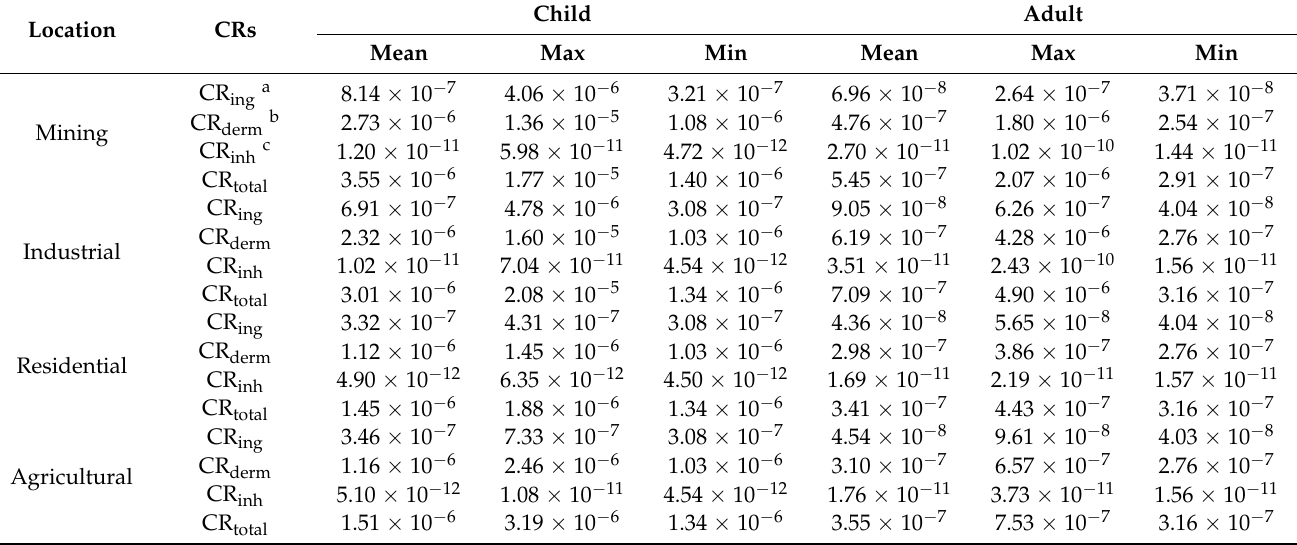
Table 2. Cancer risks for local children and adults on exposure to ∑ (16APHs + APAHs) via vari- ous